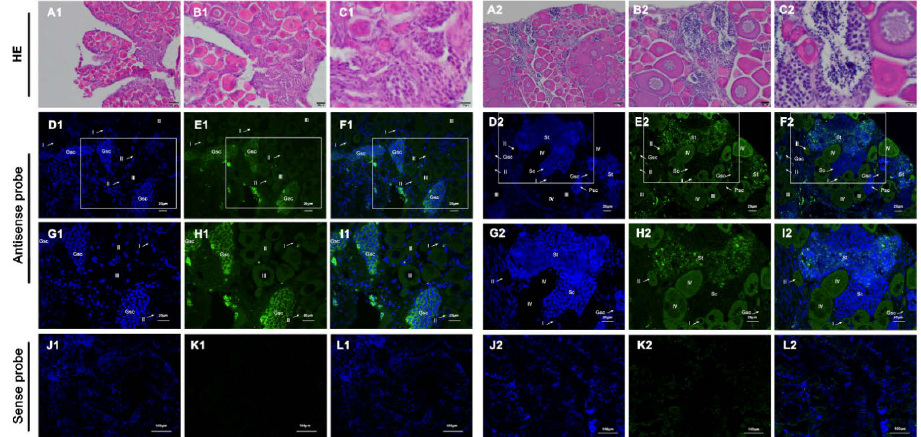
Figure 5. Localization of Plvasa RNA by fluorescence in situ hybridization (FISH) and histology. ( A1 – L1 , A2 – L2 ) were 6-month-old and adult (with intersexual gonads) fish, respectively.